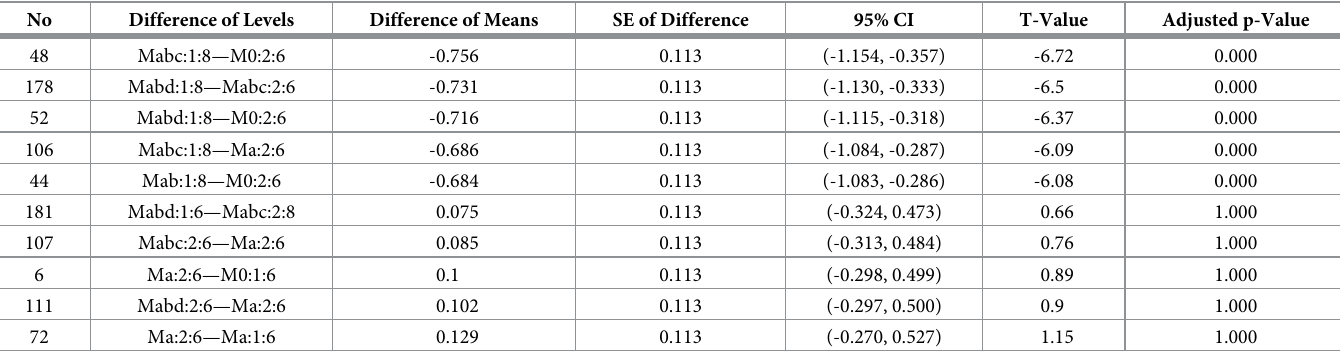
Table 9. Results of mean differences.